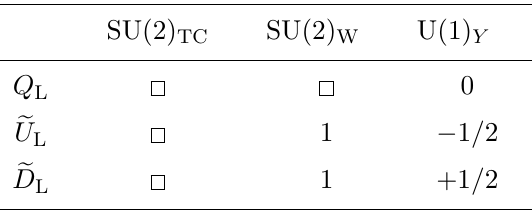
Table 1 . New fermion